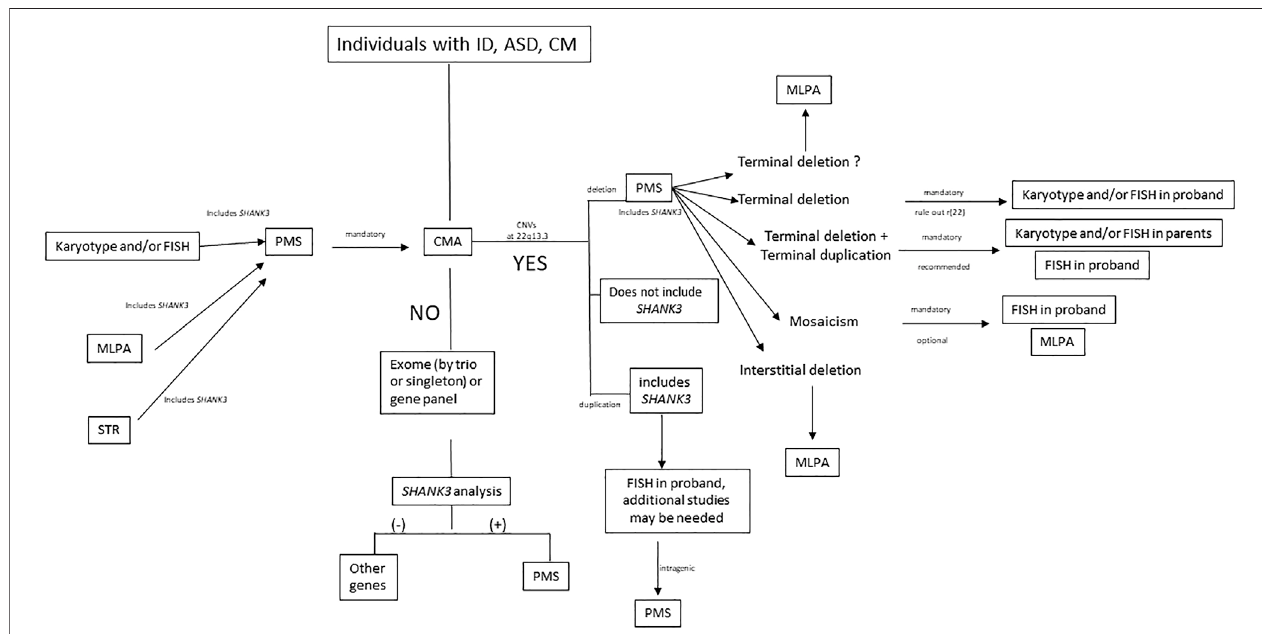
FIGURE 7 | Laboratory algorithm for management of samples suspected of PMS. ID, intellectual disability; ASD, autism spectrum disorder; CM, congenital malformations; PMS, Phelan-McDermid syndrome; CMA, chromosome microarray analysis; MLPA, multiplex ligation-dependent probe ampli fi cation; STR, short tandem repeat; CNV, copy number variation; r(22), ring chromosome